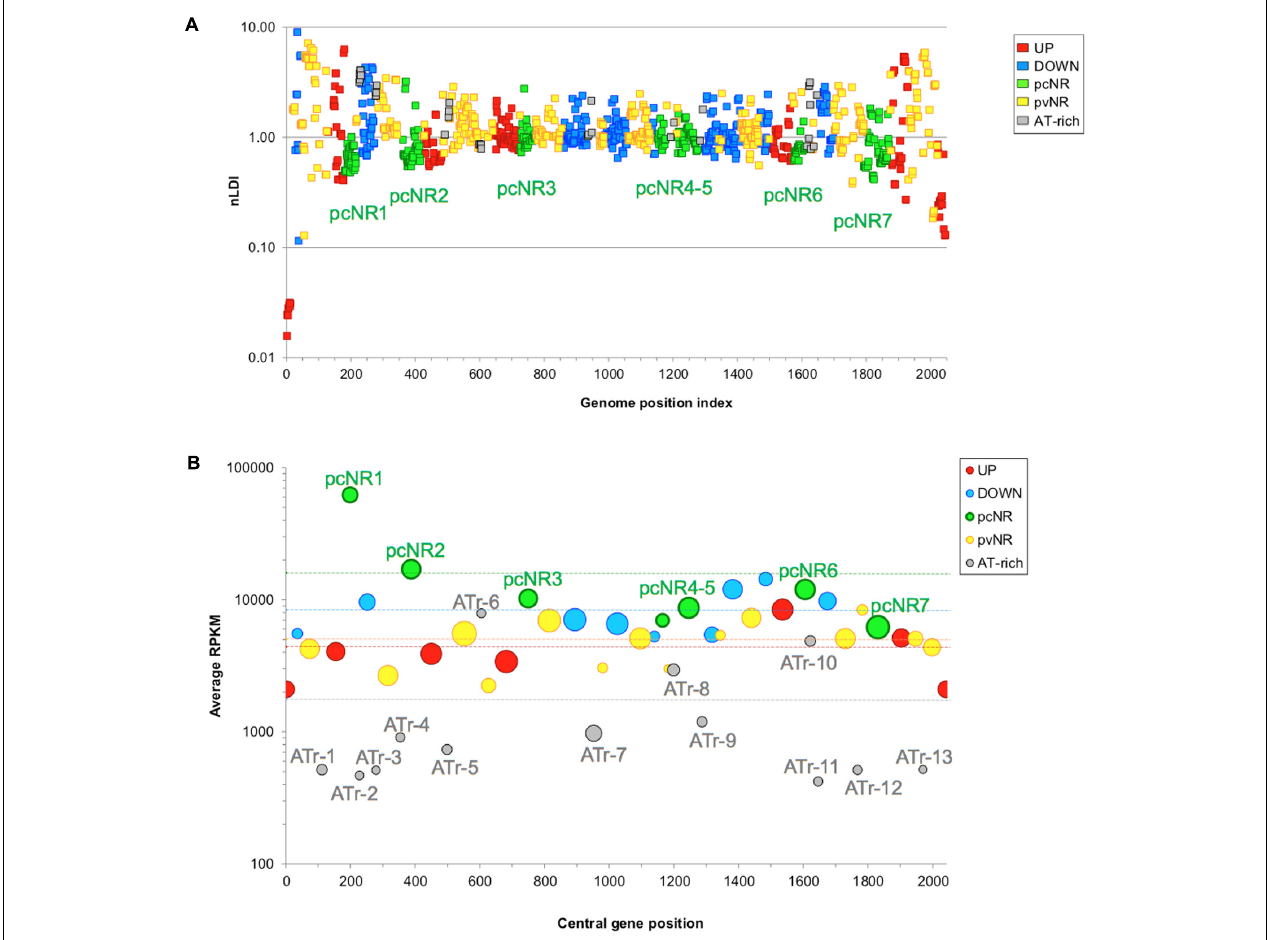
FIGURE 11 | Different domains have different locations and transcription levels. (A) Location of NOV-reactive and pcNR domains. Dots indicate nLDI values for S. pneumoniae R6 genes for the whole Streptococcus genus. A total of 1216 genes coding for proteins in S. pneumoniae R6, with homologs in ≥ 10 species, were contemplated in the analysis. Gene indexing starts from the replication origin. (B) Abundance of RNA transcripts according to domain type. RNA-Seq data were normalized by gene size (kb) using the reads per kb per million mapped reads (RPKM). The positions of the domains in the genome are represented by the position of the central gene (central gene position, X -axis). The size of the circles is proportional to the number of genes in the domain. Only pvNR clusters with at least 10 members are shown. Horizontal lines in the corresponding color indicate the average RPKM value for each domain class. Taken from Martín-Galiano et al.